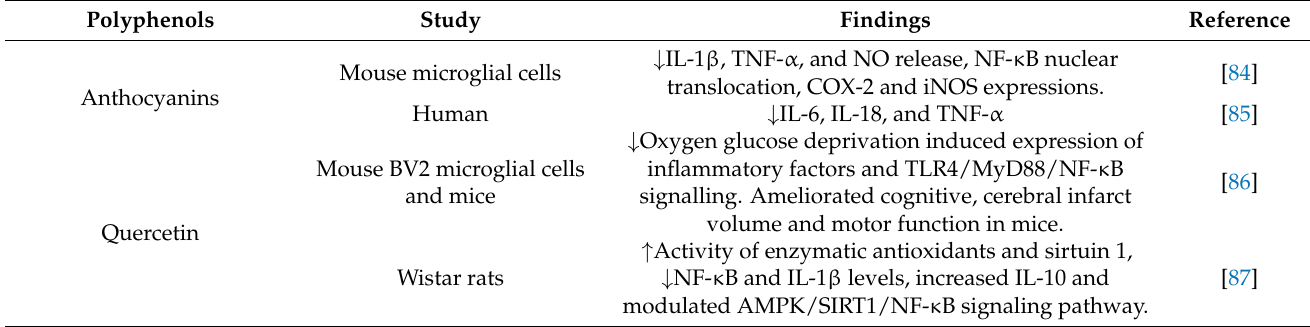
Table 2. Summary of the effects of polyphenols on oxidative stress and inflammation (biomarkers). Polyphenols Study Findings Reference Mouse microglial cells translocation, COX-2 and iNOS expressions. Anthocyanins Human Mouse BV2 microglial cells and mice Quercetin Wistar